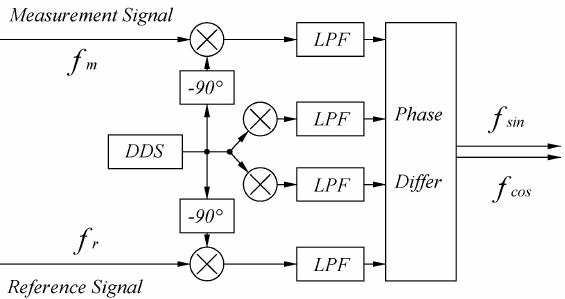
Figure 18. The principal block diagram of the double quadrature lock − in amplification